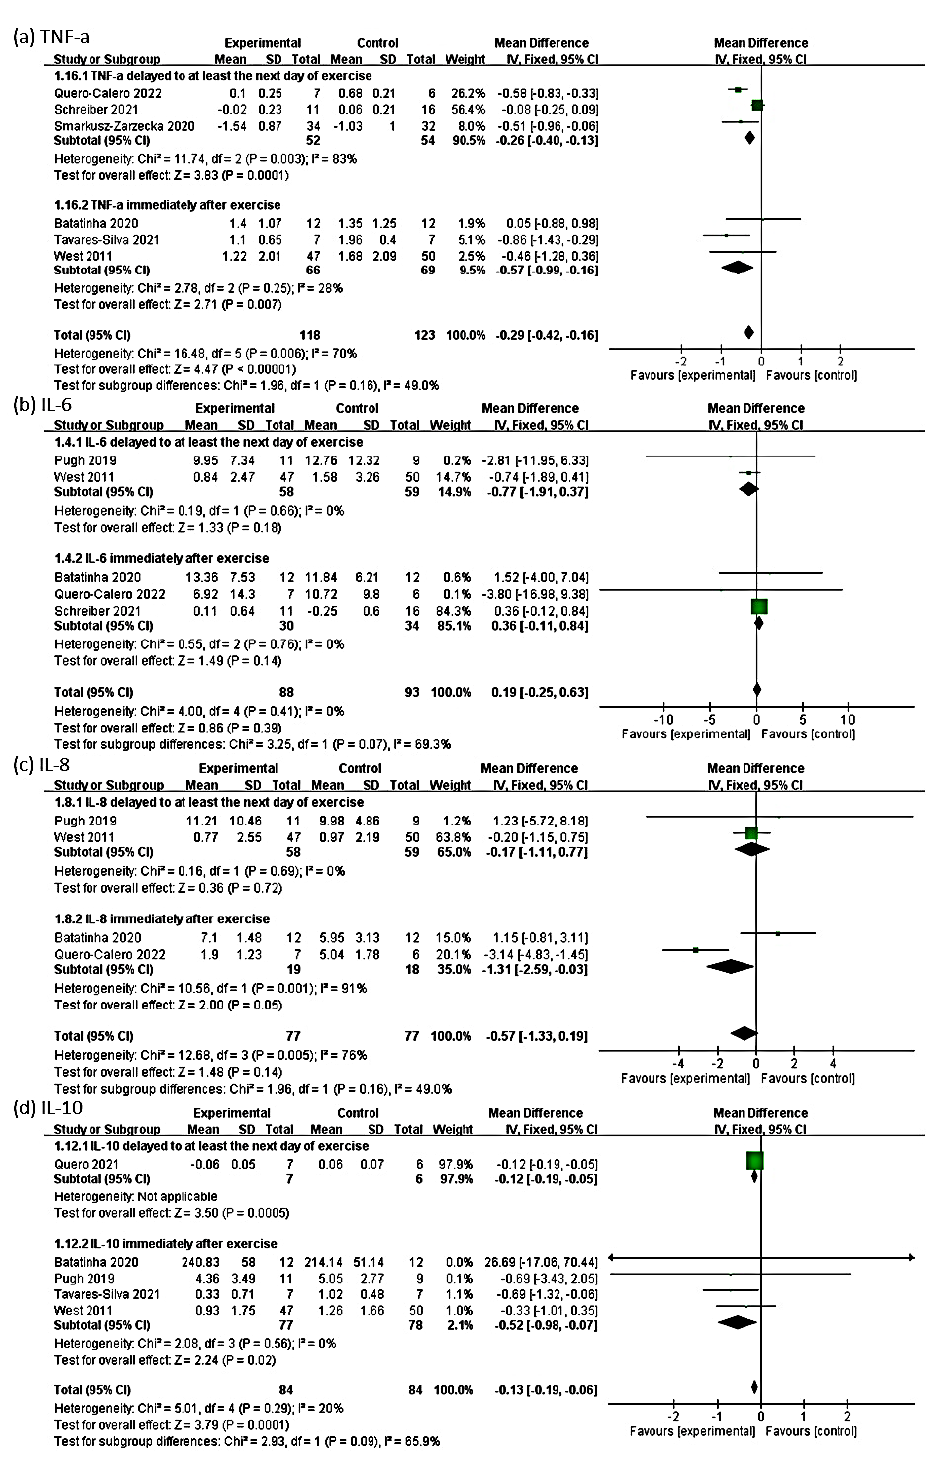
Figure 6. Forest plots of the mean effect size for the subgroups with sample collection delayed to at least the next day of exercise and immediately performed after exercise for ( a ) TNF − α , ( b ) IL − 6, ( c ) IL − 8, and ( d ) IL − 10.